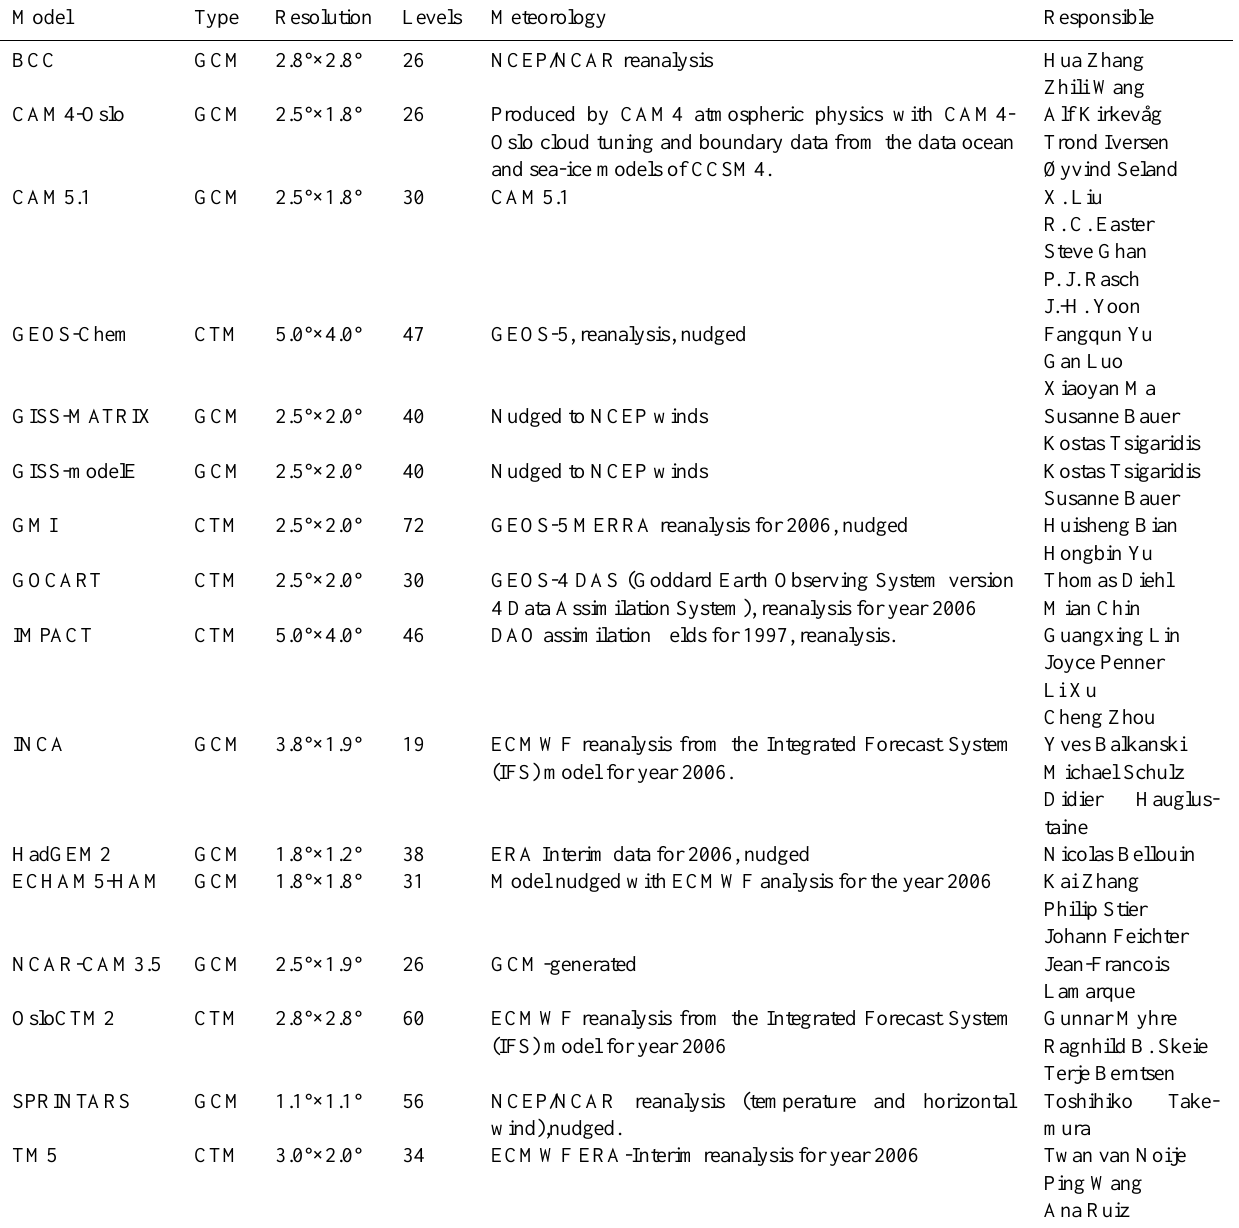
Table 1. Model description, general information. If meteorology was nudged or driven by reanalysis fields, the year 2006 meteorology was